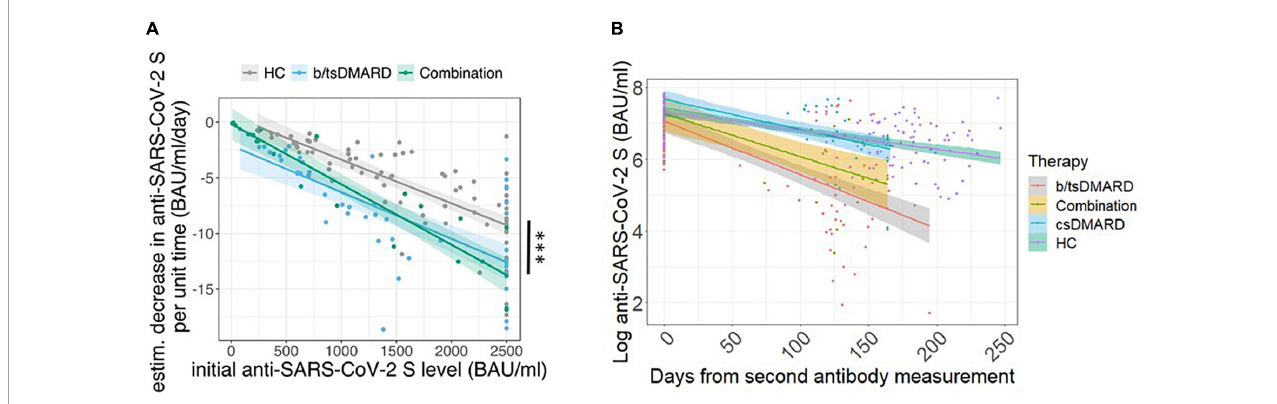
FIGURE2 (A) Rate of decline in anti-SARS-CoV-2 S titers at a given peak antibody titer according to the indicated treatment: b/tsDMARDs ( n = 54; light blue) and a combination of csDMARDs and b/tsDMARDs ( n = 28; green) in patients vs. HC ( n = 85; gray). Colored lines indicate linear regression. Thick colored lines indicate the mean slopes of the indicated patient group or HC. Indicated p- values are derived from a linear regression model with the estimated decrease (BAU/ml/day) as predicted variable and initial anti-SARS-CoV-2 S titers, therapy, and age as independent variables. Statistics used: Kruskal–Wallis test and subsequent Dunn’s test. (B) Decline of anti-SARS-CoV-2 S titers from peak levels after the second immunization and the 6-month time point in HC ( n = 85; green) and patients receiving csDMARDs ( n = 23; blue), b/tsDMARDs ( n = 47; gray), and a combination of csDMARDs and b/tsDMARDs ( n = 14; yellow). Thick colored lines indicate the mean slopes of the indicated patient group or HC. ns: non significant p > 0.05; * p ≤ 0.05; ** p ≤ 0.01; *** p ≤ 0.005; and **** p ≤ 0.001.